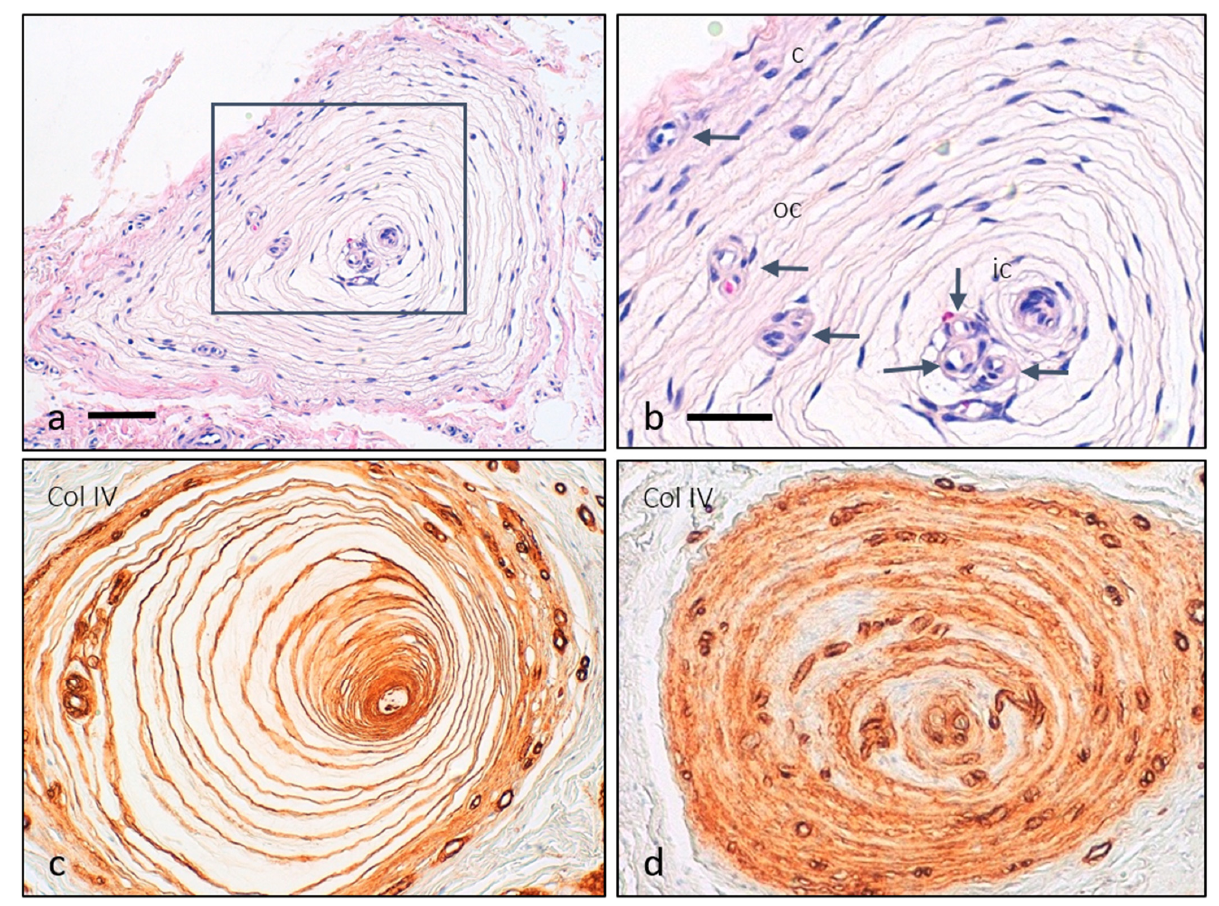
Figure 3. Capillaries in Pacinian corpuscles. The Pacinian corpuscle from Figure 2 is displayed with haematoxilin ‐ eosin staining to identify the different corpuscular regions, including the capsule (c), outer core (oc), and inner core (ic); arrows indicate capillaries (( a ), detailed in ( b )). Typically, only the capsule of human Pacinian corpuscles contains capillaries, highlighted with type IV collagen immunostain in a typical control corpuscle, where only the peripheral capsule contains capillaries ( c ). Nevertheless, in those from fibromatosis disease, capillaries are present in all the corpuscular compartments ( d ). Table 2. Immunohistochemical profile of Pacinian corpuscles in normal plantar fascia (C) and plan ‐ tar fibromatosis (PF). Quantification of the immunostain was performed considering absence of ex ‐ pression ( − ), faint expression (+), intermediate expression (++), and strong expression (+++).